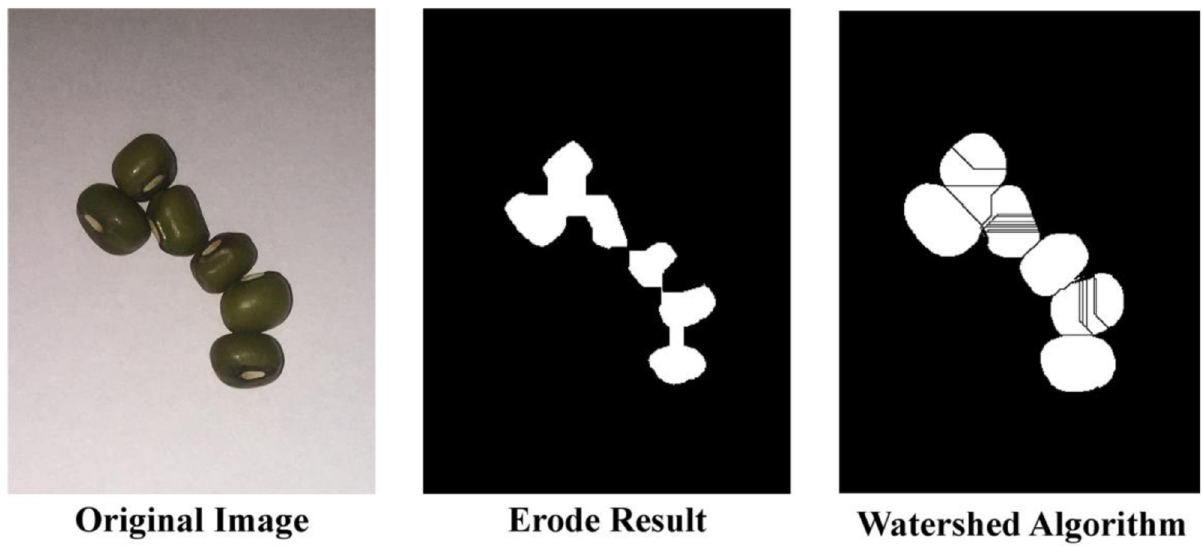
Fig 12. Results of corrosion and watershed analysis method of mung bean